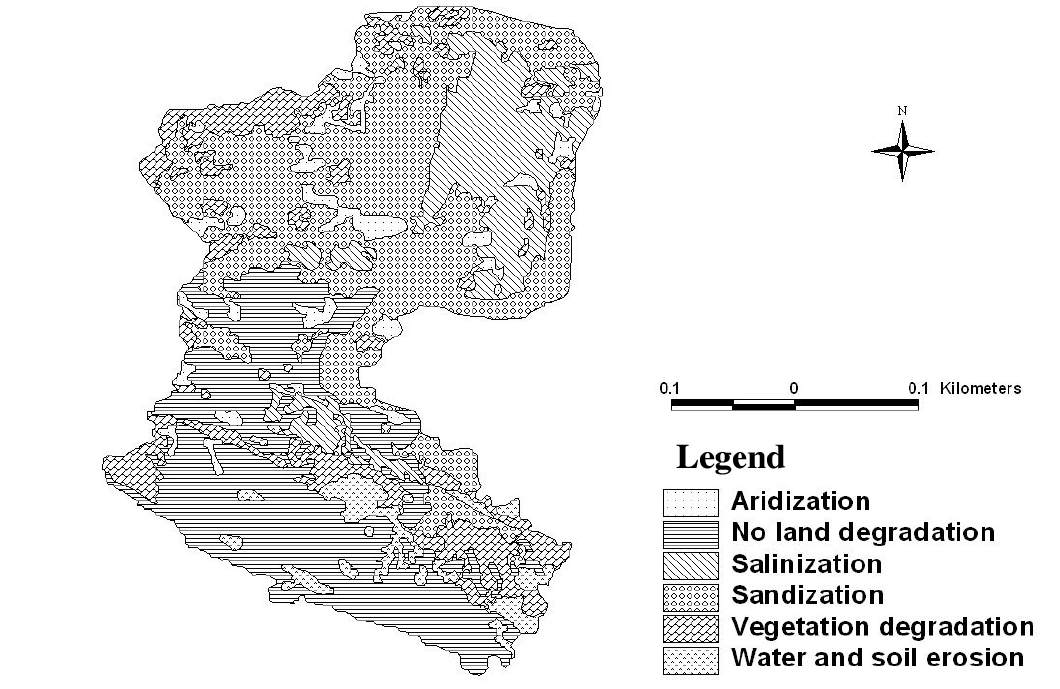
Figure 2. Spatial distribution of degraded land in the Heihe River Basin (Note: In the study area, no degraded land includes lakes, forests, oases, undegraded grasslands and residential areas